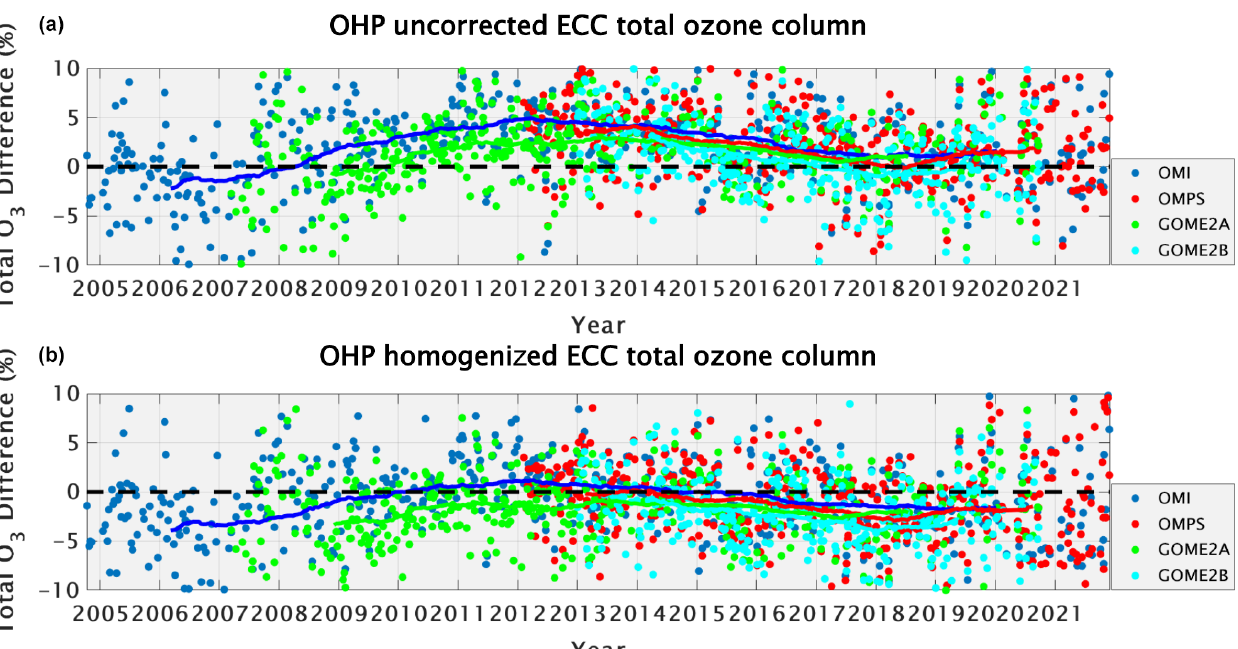
Figure 9. Relative differences ECC minus satellite total ozone column (in %) before (a) and after (b) homogenization. The thick lines are 100-point, centered, moving averages. No moving averages are plotted for less than 100